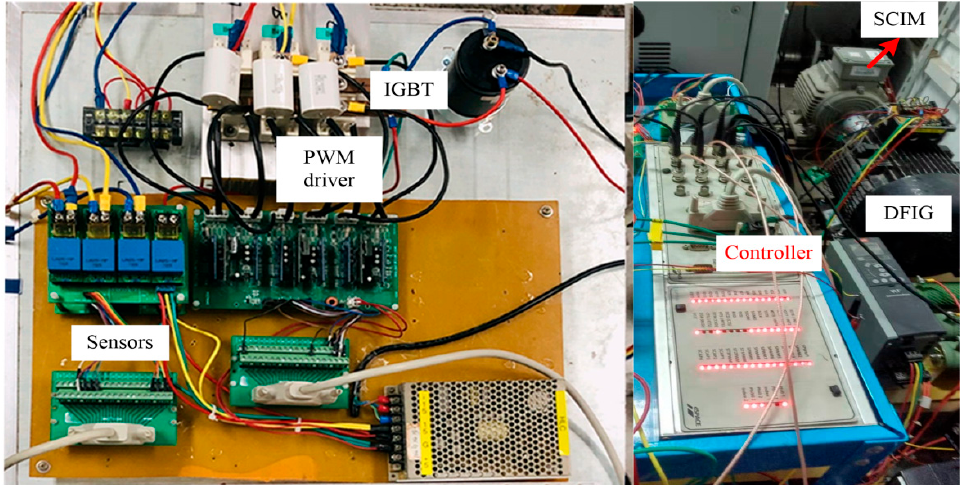
Figure 24. Experimental set up of the proposed DFIG system.